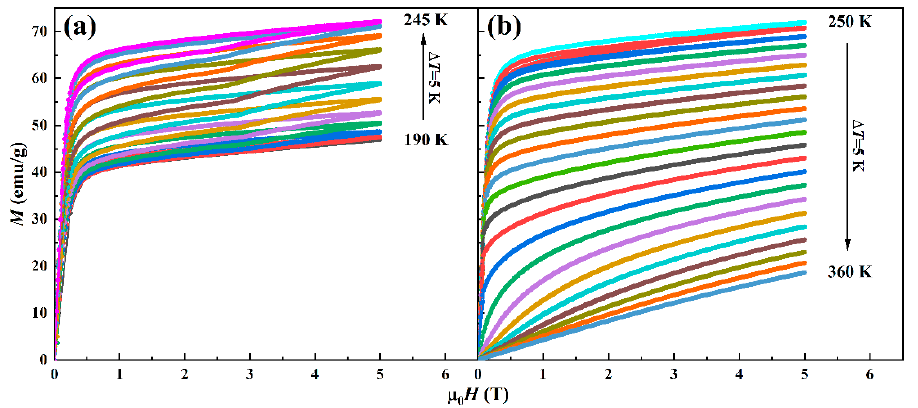
Figure 5. Selected isothermal magnetization curves under different temperatures with an applied magnetic field up to 5 T according to the thermomagnetic curves. ( a ) Around martensitic transformation. ( b ) Around magnetic transformation.